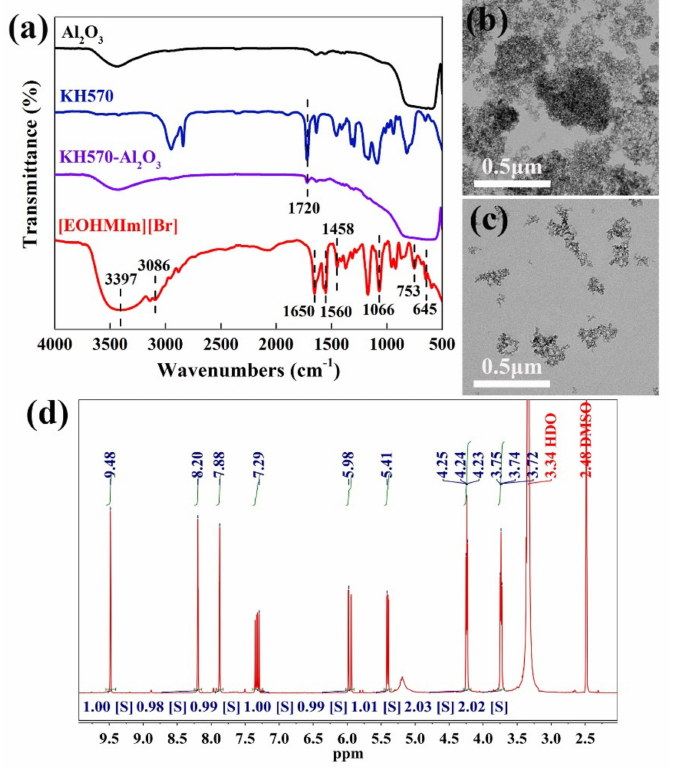
Figure 4. ( a ) The FTIR spectra of Al 2 O 3 , KH570, KH570-Al 2 O 3 and [EOHVIm][Br]. TEM images of ( b ) Al 2 O 3 and ( c ) KH570-Al 2 O 3 . ( d ) The 1 H-NMR spectrum of the